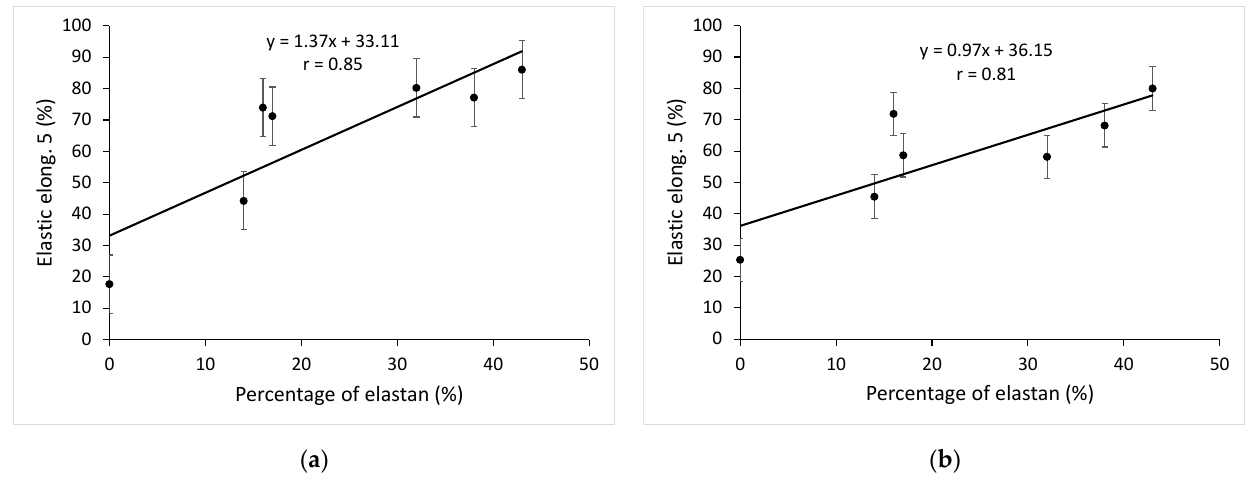
Figure 9. Relation between the percentage of elastane in the knitted fabric and the value of the elastic elongation of the knitted fabric in the fifth cycle of cyclic loading–unloading: ( a ) in the wale direction; ( b ) in the course direction.